Question: What type of chart is this?
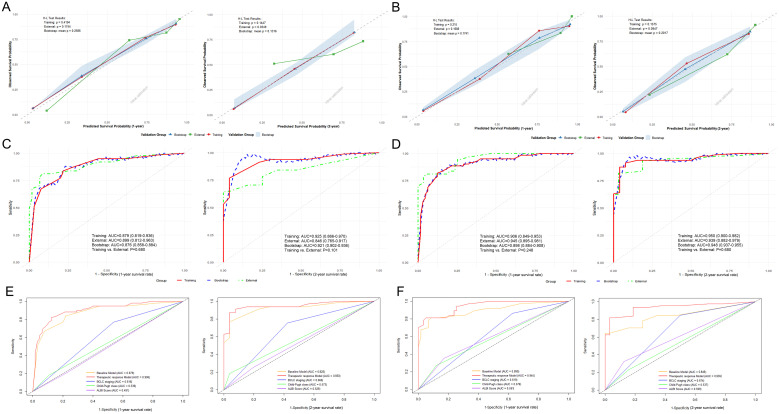
Answer: line